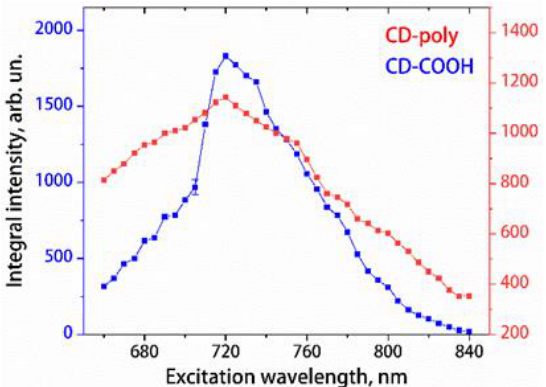
Figure 6. Dependences of the integrated UCL intensities of aqueous solutions of CD-poly and CD-COOH on the wavelength of the exciting radiation (pH = 11.7).